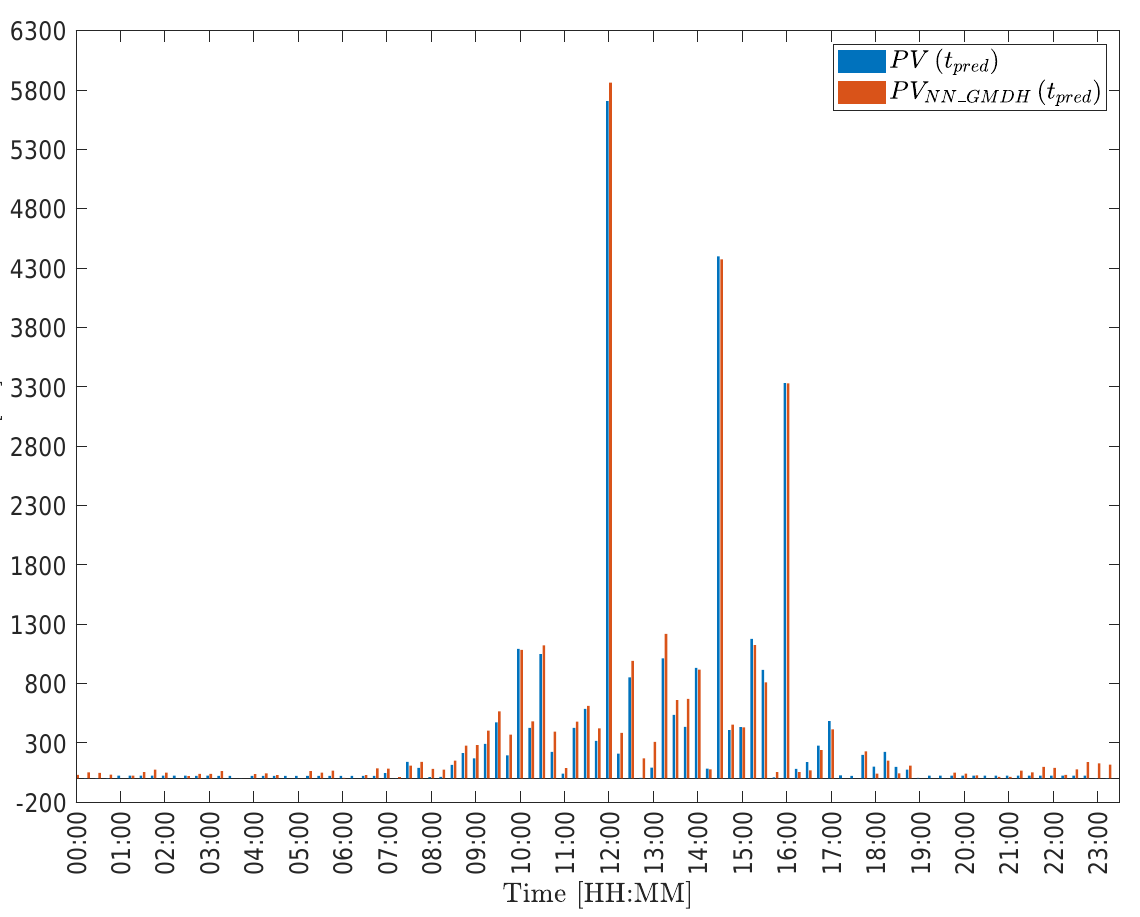
Figure 2. Power values generated by photovoltaic panels ( PV ) compared with the power value predicted by the neural predicting model ( PV NN _ GMDH